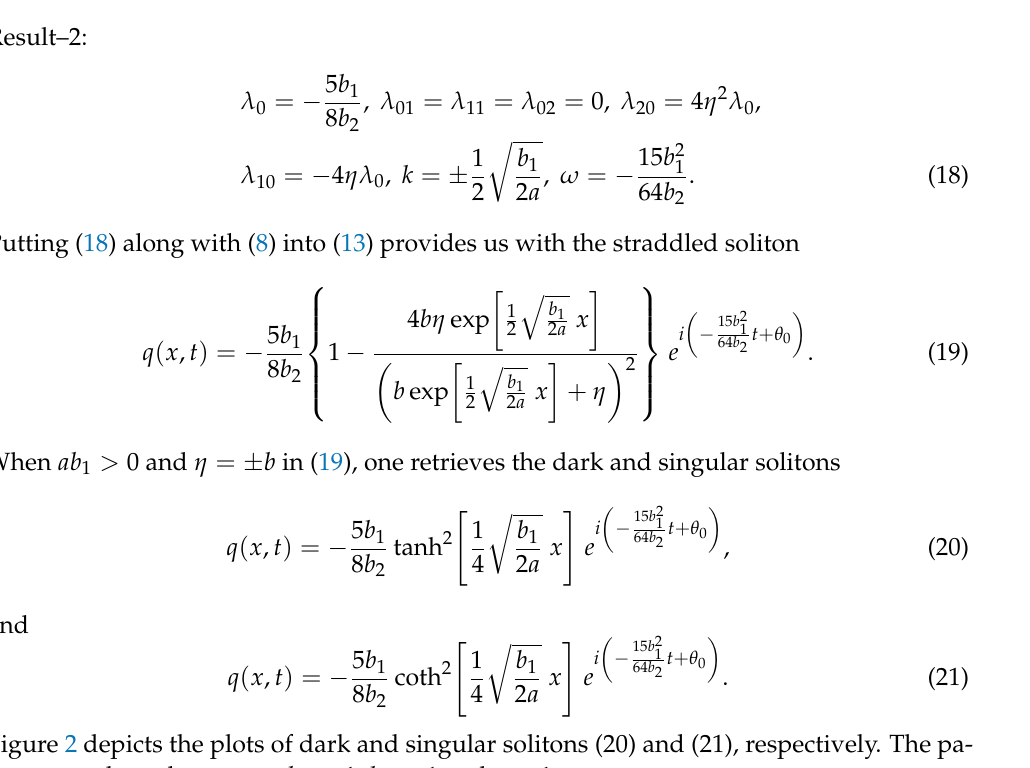
Figure 1. Profiles of stationary dark and singular solitons,